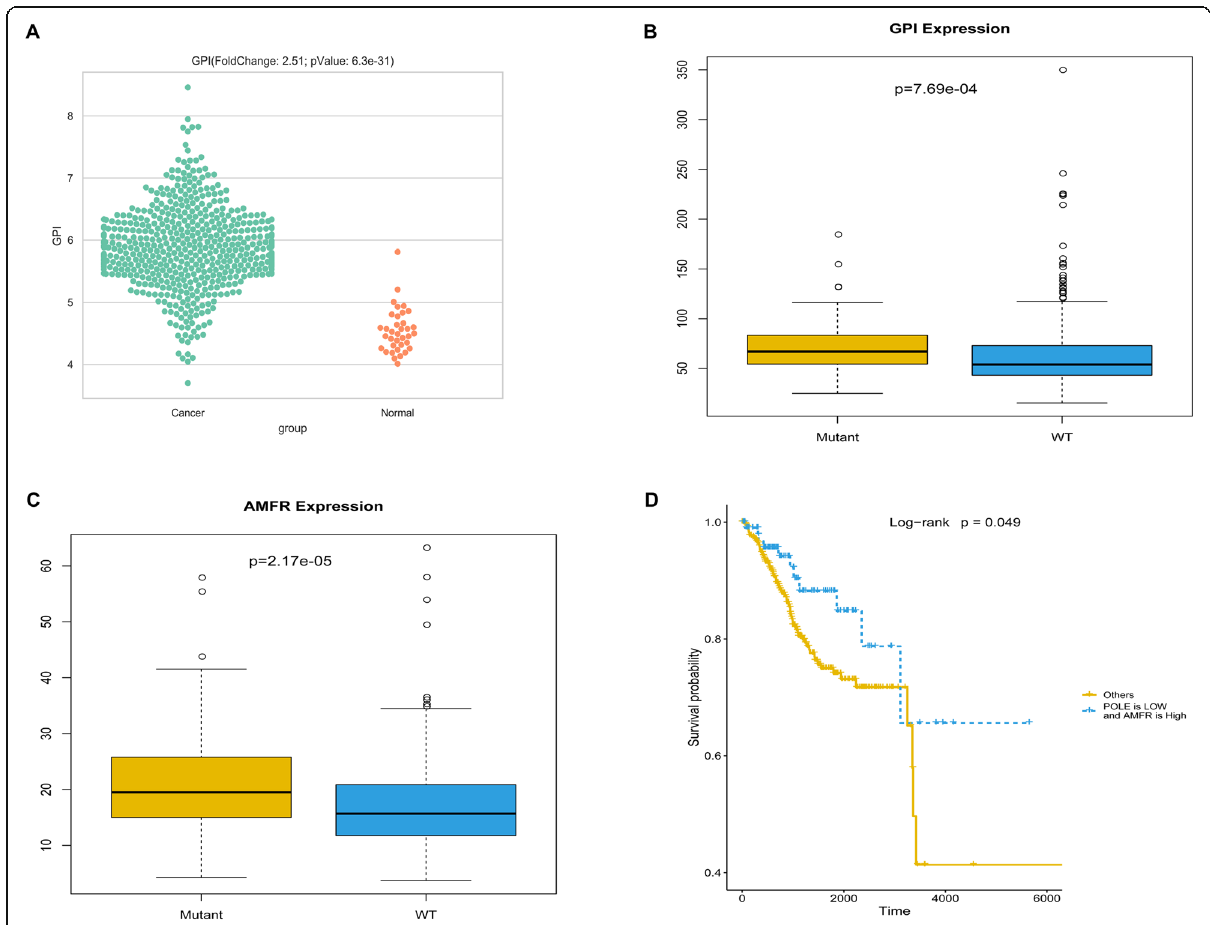
Fig. 5 POLE mutations regulate cellular metabolism through enhancing AMF/PGI and AMFR/gp78 expression. a The expression of AMF/PGI in endometrial cancer patients and normal samples, Normal = 35, Cancer= 551. The Y axis represents the expression of the gene (log 2 FPKM). b The expression of AMF/PGI in mutant and wild type POLE endometrial cancer samples, Mutant = 80, wild type = 446. The Y axis represents the expression of the gene (FPKM). c The expression of AMFR/gp78 in mutant and wild type POLE endometrial cancer samples, Mutant = 80, wild type = 446. The Y axis represents the expression of the gene (FPKM). d Kaplan – Meier curve and log-rank test for endometrial cancer